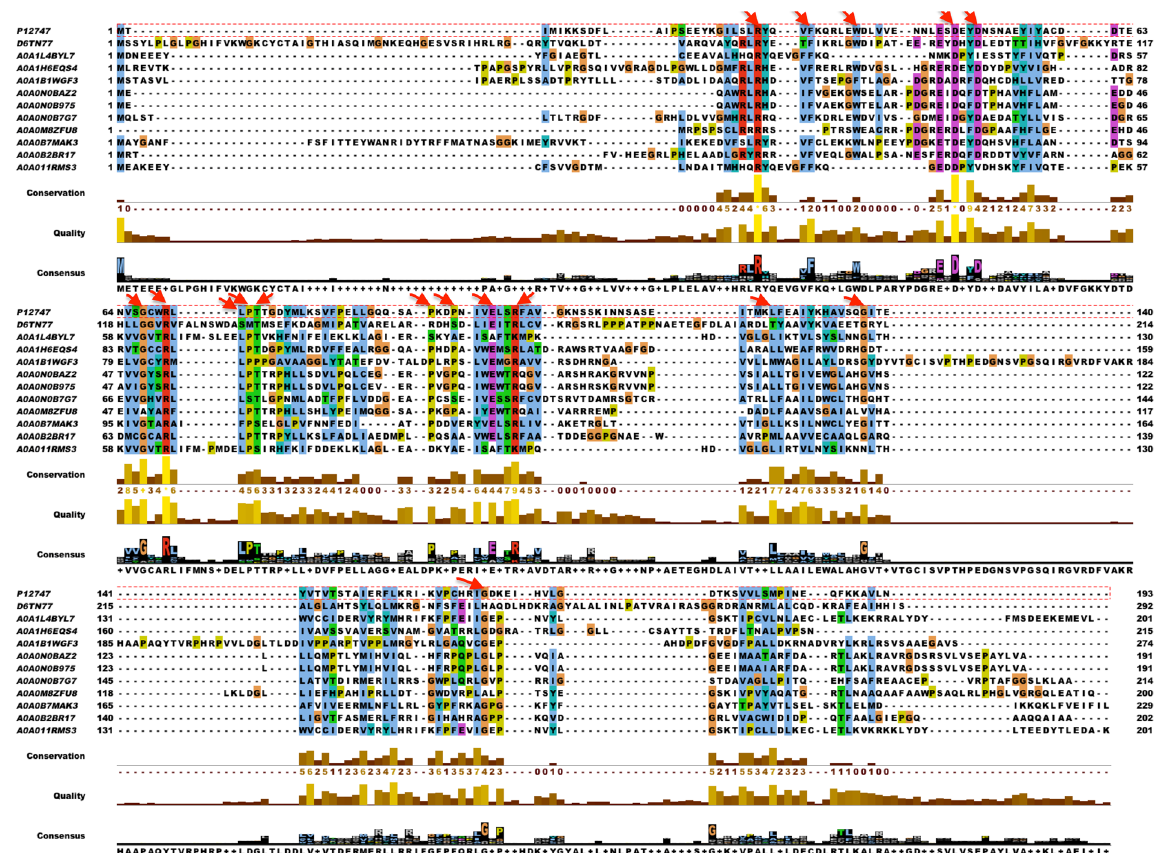
Figure 3. Multiple Sequence alignment of 11 LuxI containing sequences against V . fischeri LuxR sequence using MAFFT and visualized using Jalview software.